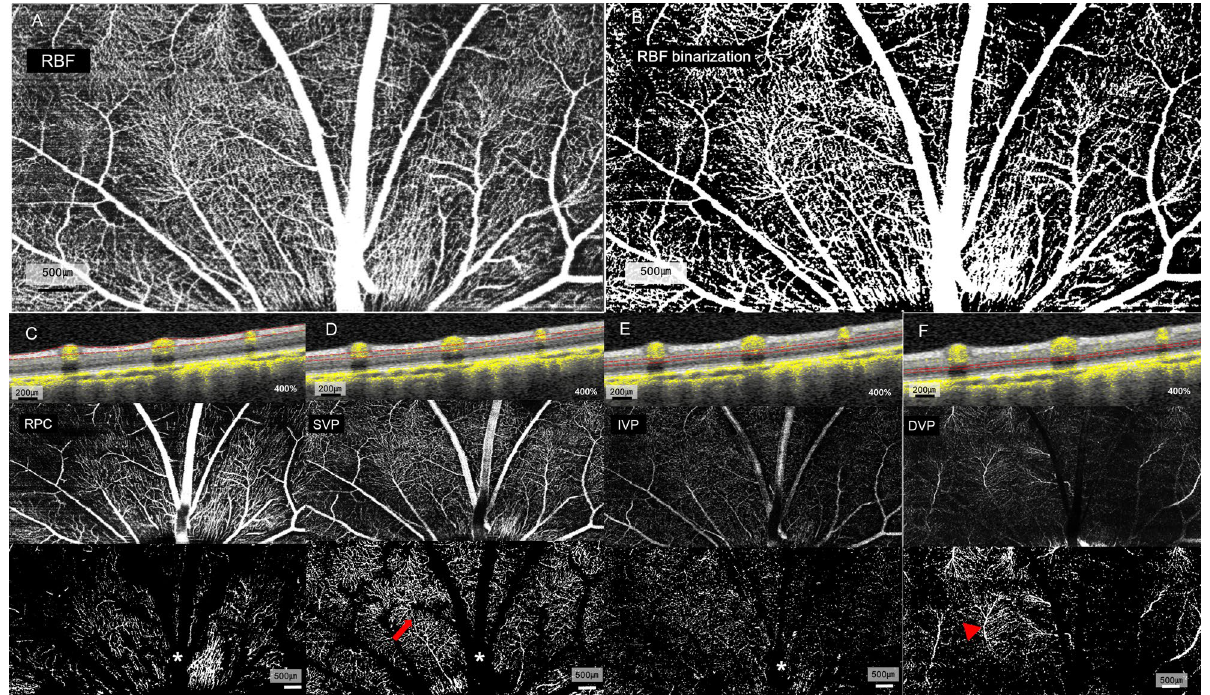
Figure 1. Segmentation of the retinal vascular layer. ( A ) Total retinal blood flow layer from the internal limiting membrane to the outer plexiform layer. ( B ) Binarization image of total retinal blood flow. ( C ) Radial peripapillary capillaries from the inner nuclear layer to the retinal nerve fiber layer showed long capillaries running parallel to the nerve fiber layer. ( D ) Superficial vascular plexus from ganglion cell layer to the inner margin of the inner plexiform layer showed arborescent patterns with central arterioles (red arrow). ( E ) Intermediate vascular plexus from the inner plexiform layer to the inner margin of the inner nuclear layer had no prominent arterioles or venules. ( F ) Deep vascular plexus from the inner nuclear layer to the outer plexiform layer showed prominent central venules (red arrowhead) and arborescent capillaries. ( C – F ) (upper) In fusion images of structural OCT section images and the corresponding blood flow information (structural OCT + OCTA) (magnification × 4), direct visual confirmation of structural and flow information (yellowish dot overlay) in each vascular plexus was established by the user. (middle) En-face OCTA images and (lower) binarized images of en-face OCTA images. Major cilioretinal vessels were manually removed in binarized images of RPC, SVP, IVP (white asterisk in C – E